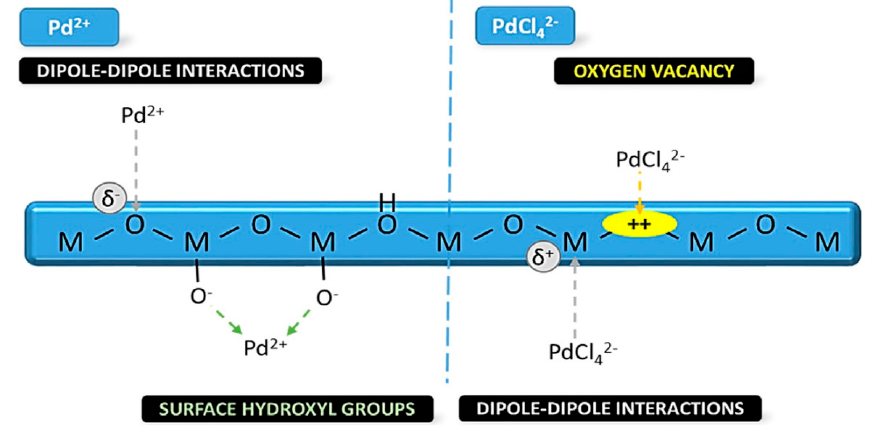
Figure 4. Schematic illustration of Pd interactions with surface sites or the oxygen vacancies formed on reducible metal oxide. Adapted with permission from [9].